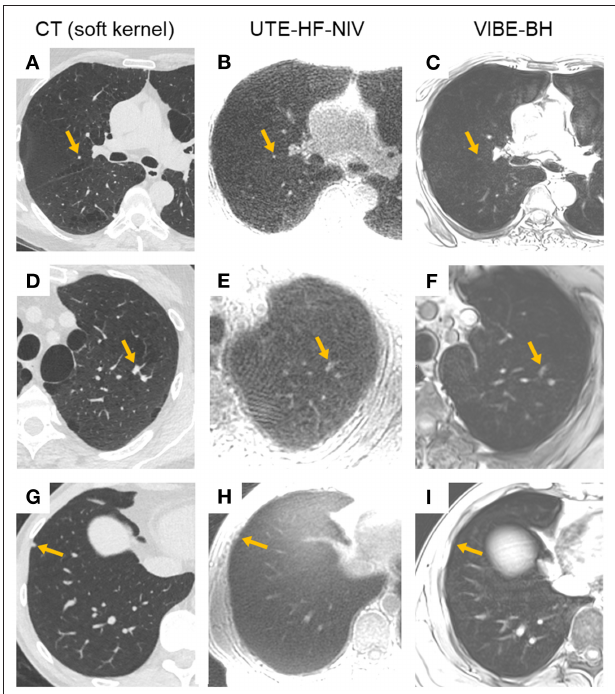
FIGURE 2 | Examples of nodules not reported in MR analyses. (A–C) CT, UTE-HF-NIV, and VIBE-BH images of the right upper lobe showing a juxta-fissural nodule of 4-mm long axis (orange arrow), respectively. While visible in UTE-HF-NIV image (B) , its long axis was measured < 4mm, hence not reported. The nodule was scarcely seen in (C) . (D–F) CT, UTE-HF-NIV, and VIBE-BH images of the left upper lobe with 2 nodules of 9mm (orange arrow) and 6-mm-long axis, respectively. Due to a loss in morphological characteristics in both MR images, and although the neighboring nodule was easily recognized, the largest finding was considered as a parenchymal band instead of a nodule for two of the three readers, and as a nodule for the